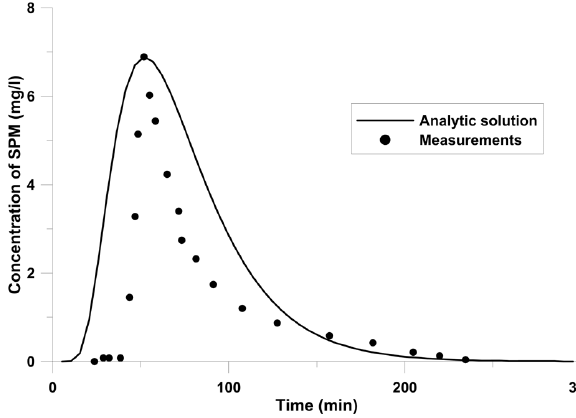
Figure 7. Calculated and measured variation in SPM concentration with time for the first and Fig. 7. Calculated and measured variation in SPM concentration initiating event in the Agnesberg landslide using a dispersion coefficient of D = 230 m 2 s -1 . with time for the first and initiating event in the Agnesberg land- slide, using a dispersion coefficient of D =230m 2 s − 1